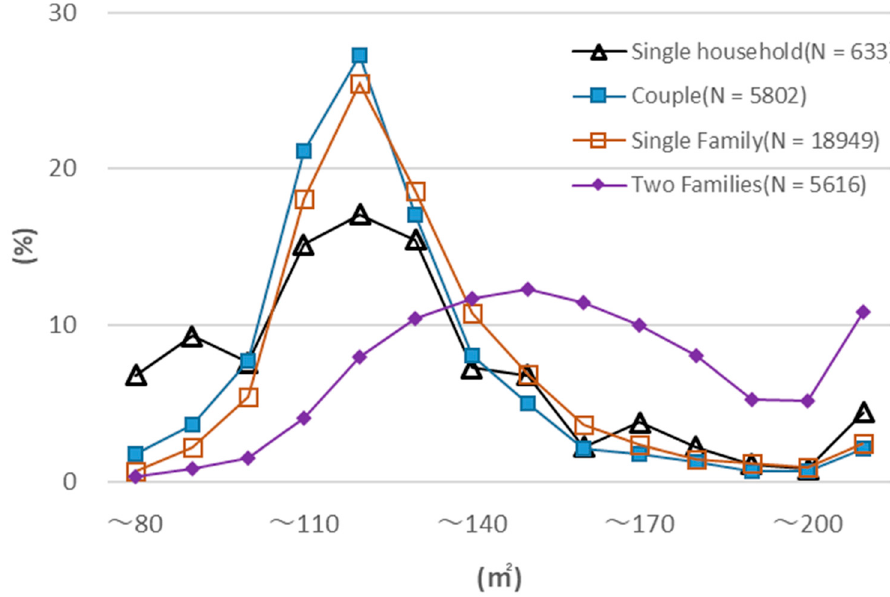
Figure 3. Family type-based ratio of floor area (Zone 6).